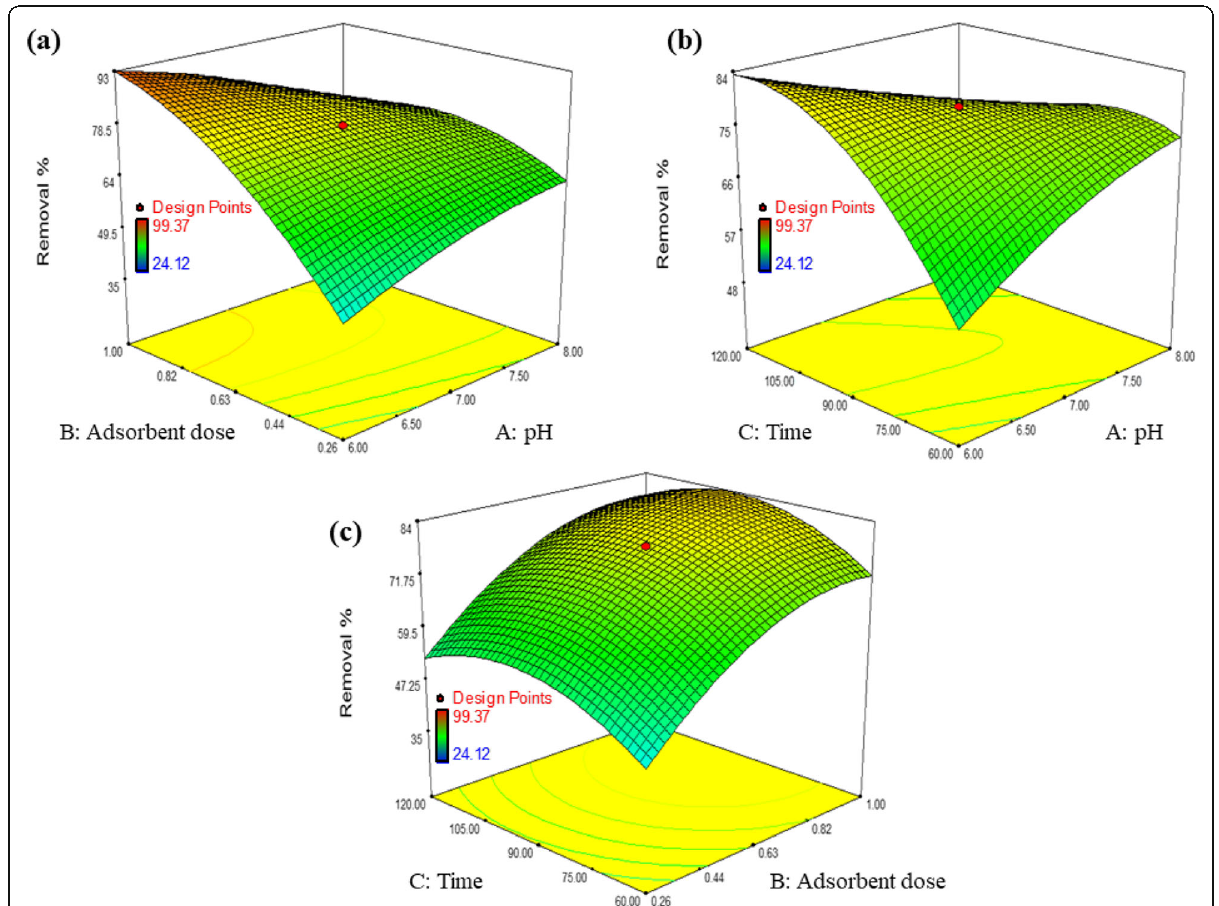
Fig. 4 Inter-parameter interactions and process optimization guiding Carbamazepine (CBZ) adsorption over graphene oxide (GO). Plots ( a – c ) show 3D plots illustrating impact of interactions of GO dosage vs. solution pH, solution pH vs. contact time and GO dosage vs. contact time on % CBZ removal